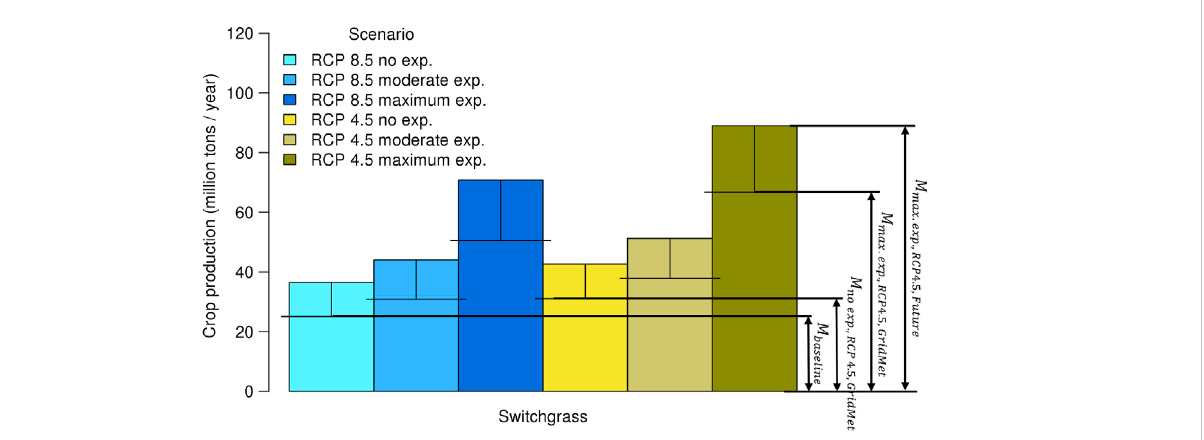
FIGURE 8 Annual production of bioenergy crops, represented by switchgrass in the extended CRB. Switchgrass production, both irrigated and dryland, was summed over all grid cells and the median calculated over the years 2046 – 2075 (future scenarios) or 1986 – 2015 (historical scenarios). The horizontal black line within (or above) each column marks the crop production value for that scenario using historical GridMet/Livneh climate data. The distance measurements show each component used to calculate Δ Clim , Δ Irr , Δ LU , and Δ Total as per Eqs 17 – 20, using RCP 4.5 maximum expansion as an example. The baseline scenarios are not shown because the bioenergy acreage was zero in the 2015 base year. Therefore, RCP 8.5 no expansion was substituted for GCAM baseline in the computation of Δ Clim , Δ Irr , Δ LU , and Δ Total . Results do not account for impact of curtailment on irrigated